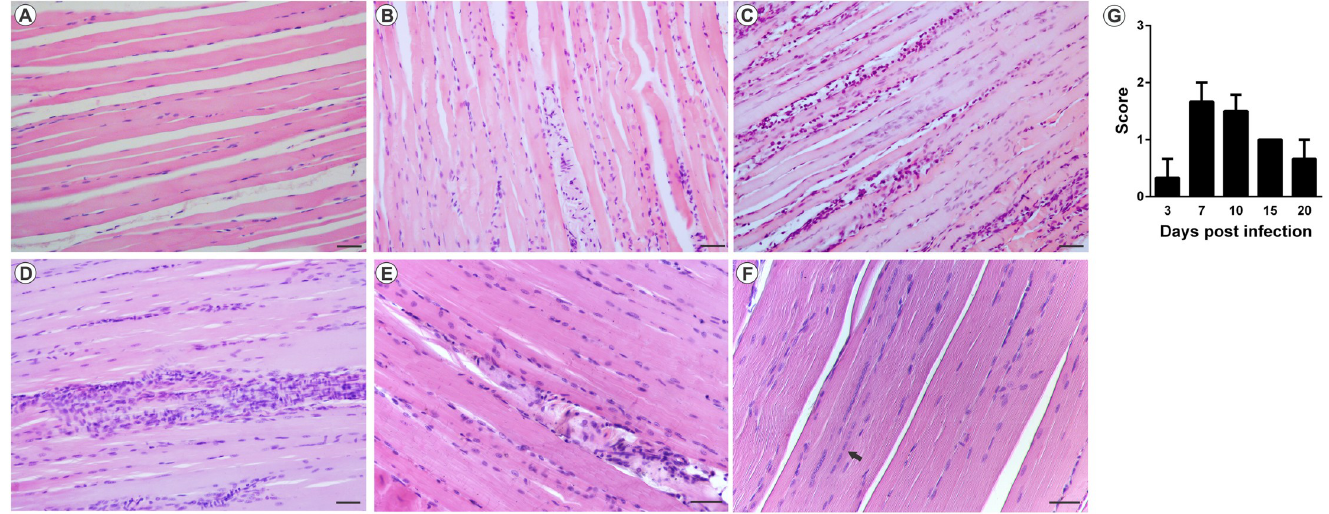
Fig 8. Mayaro virus-induced myositis in the ipsilateral muscle in mice infected via the rear left footpad with 2.57 x 10 6 PFU. Animals were sacrificed on days 3, 7, 10, 15 and 20 PI. for tissue damage analysis. The quadricep muscle was fixed in Karnovsky, embedded in paraffin, and 5 μ m sections were made and stained with HE. (A) Negative control. (B) MAYV infection at 3 days PI. (C) MAYV infection at 7 days PI. (D) MAYV infection at 10 days PI. (E) MAYV infection at 15 days PI. (F) MAYV infection at 20 days PI, with centralized nuclei (arrow). (G) Histological score. Images (200X magnification, bar 40 μ m) N = 3 animals/group.